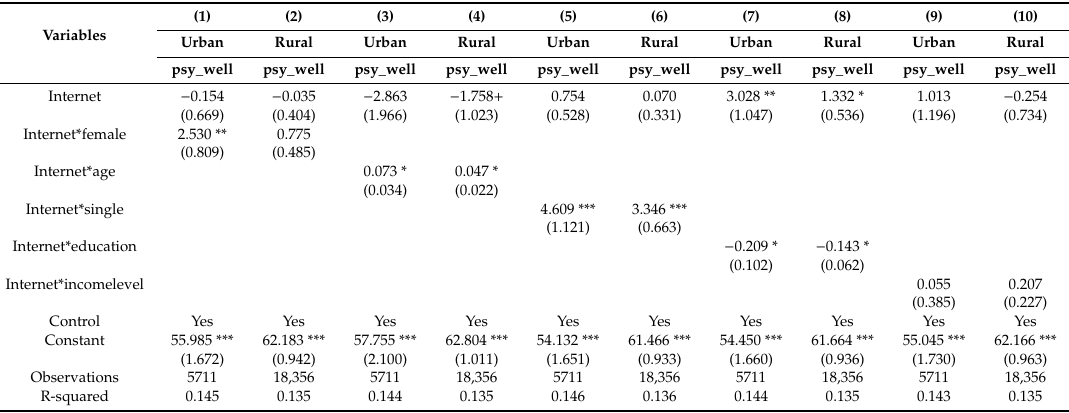
Table 6. Heterogeneity analysis of Internet use among non-agricultural and agricultural hukou holders. Variables